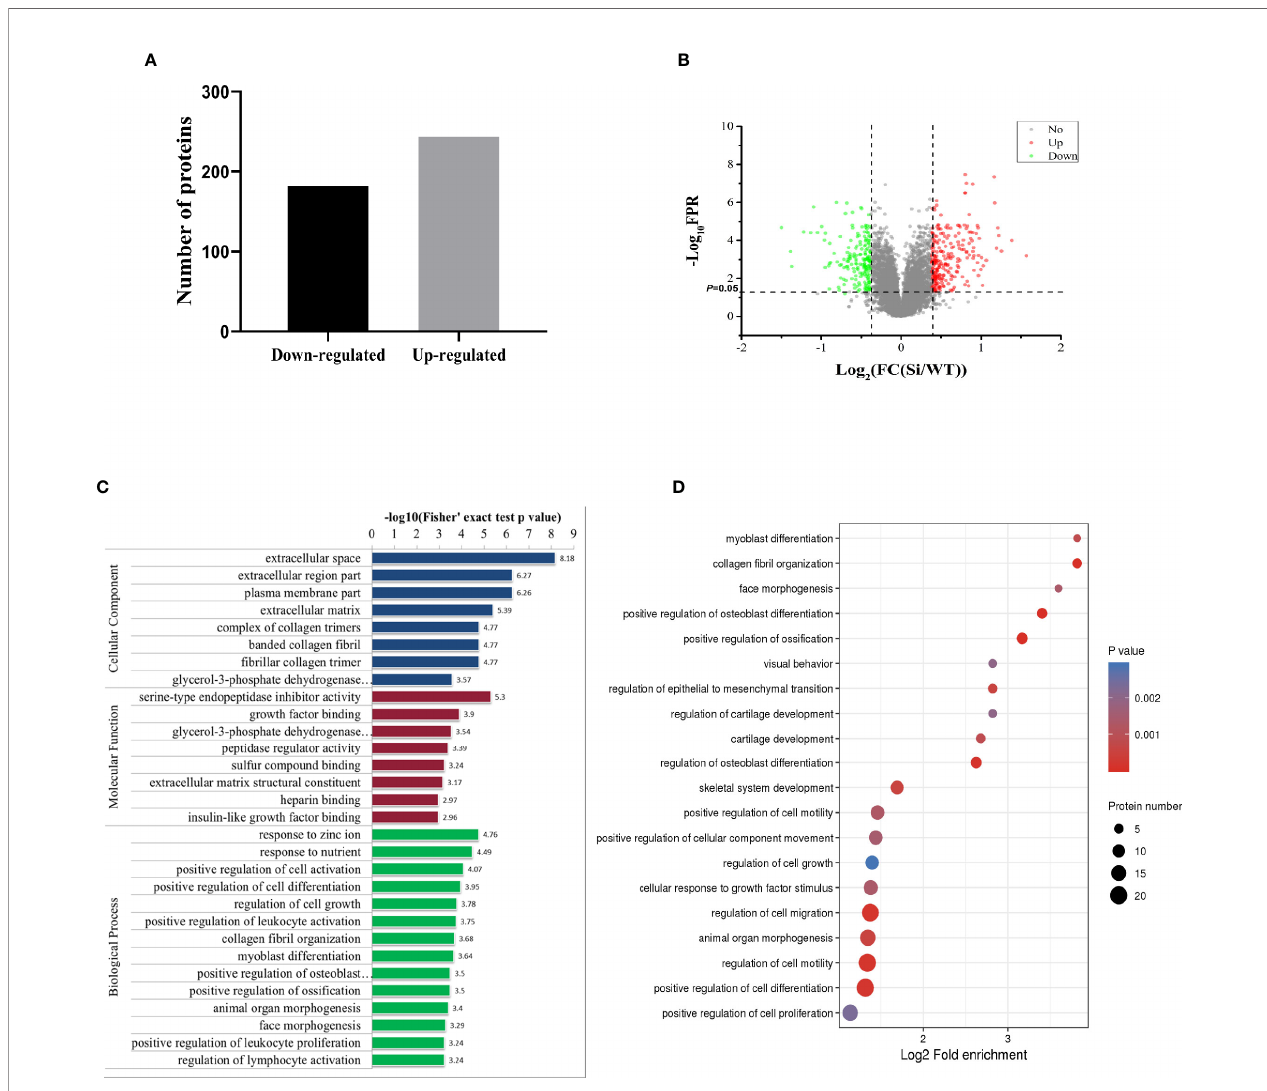
FIGURE 2 | Proteomics analysis of VHL-KD PC12 cell line. (A) A bar graph showed the differential protein analyzed by TMT labeling quantitatively. (B) The volcano map of differentially expressed proteins. The abscissa denotes the ratios of differential expression proteins in the VHL-KD PC12 cell line vs those in the empty vector- transfected cell line; the ordinate represents the P-value between the two groups. (C) Differential protein was analyzed by GO function enrichment, and GO annotations were divided into three categories: Biological Process, Cellular Component, and Molecular Function. (D) The three main categories of differential proteins obtained by GO classi fi cation were further functionally analyzed. The circle in the fi gure indicated the number of differential proteins. The shade of the circle color represented the size of the P value. The darker the color of the circle represented the smaller the P-value ; the lighter the color of the circle represented the larger the P-value